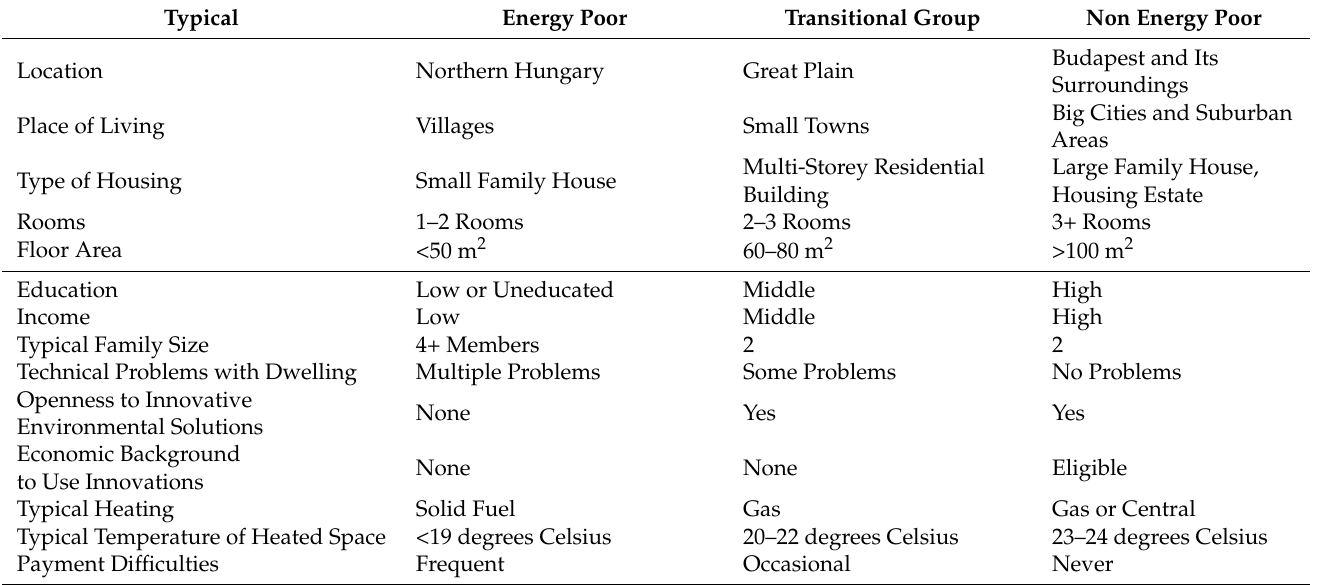
Table 3. Specific characteristics of each